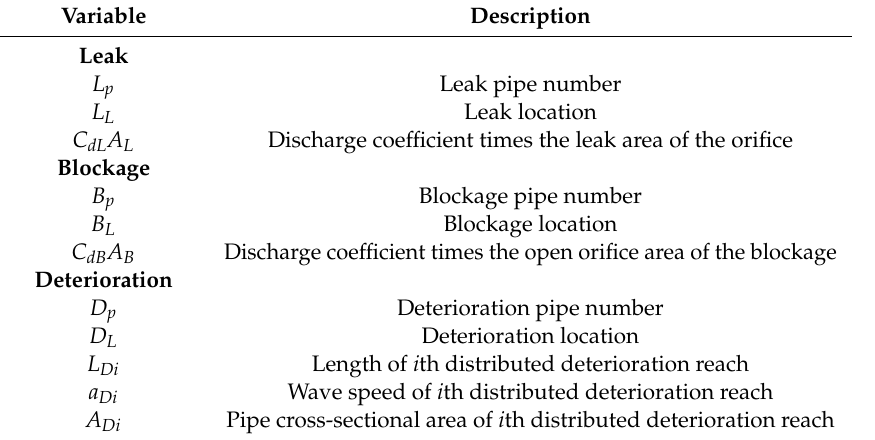
Table 1. Fault information to be